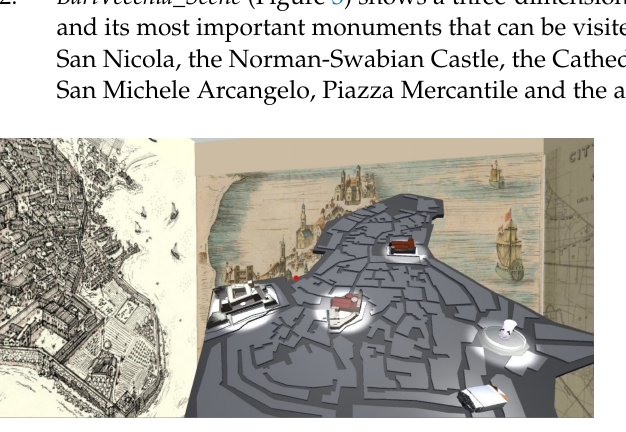
Figure 3. Scene of Bari Vecchia (the old town).